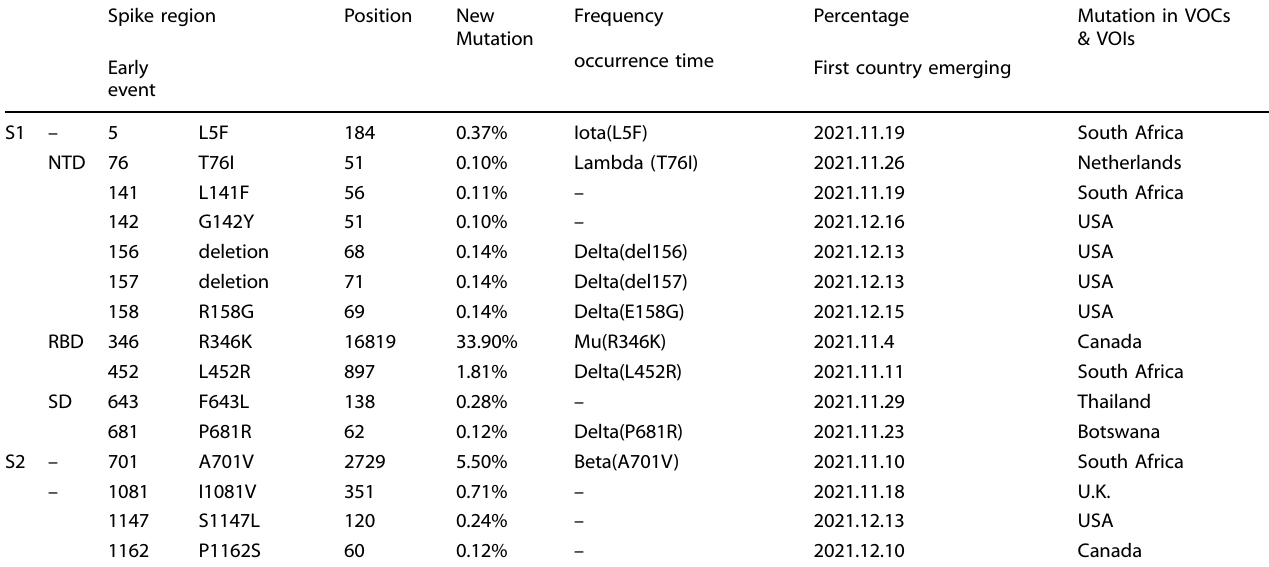
Table 2. Novel mutations identi fi ed in the spike protein of the recently emerged Omicron subvariants (emerged before 15 January 2022; frequency